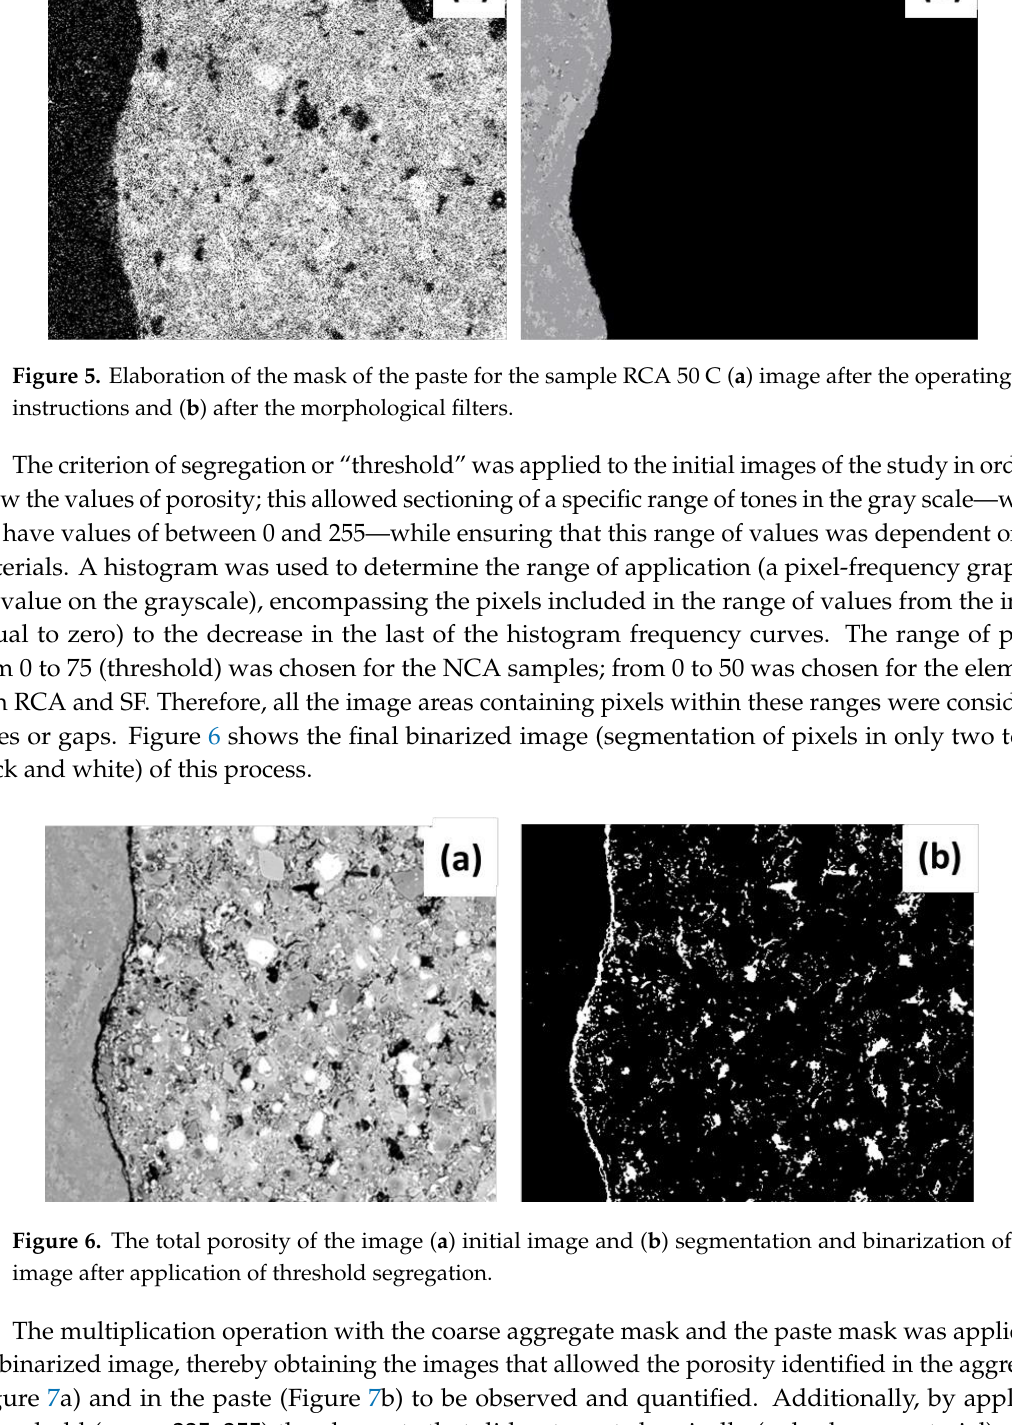
Figure 4. Preparation of the aggregate mask for the RCA 50 C sample ( a ) image after the operating instructions and ( b ) after the morphological filters.